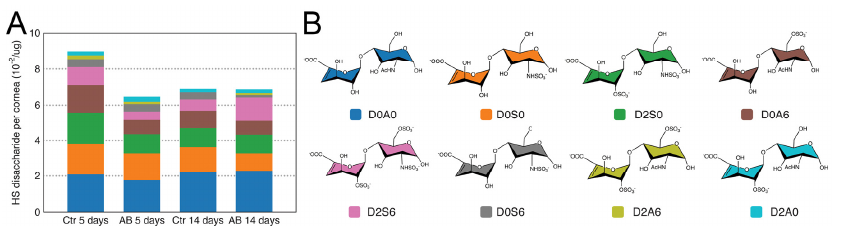
Figure 2. Disaccharide composition of HS in mouse corneas after AB. Total GAGs were extracted from seven pooled corneal tissues and digested with Heparinase in order to generate HS disaccha- rides. These were then separated by strong anion exchange chromatography using a high pressure liquid chromatography system (SAX-HPLC). The eluent was subjected to fluorescent post-column derivatization using 2-cyanoacetamide in the presence of NaOH. The disaccharide separation profiles were compared to the separation of standard disaccharides for identification, and the abundance of the different HS disaccharides in the injured and uninjured corneas represented ( A ). Representation of the chemical structure of the HS disaccharides identified in the corneal samples before and after AB ( B ).